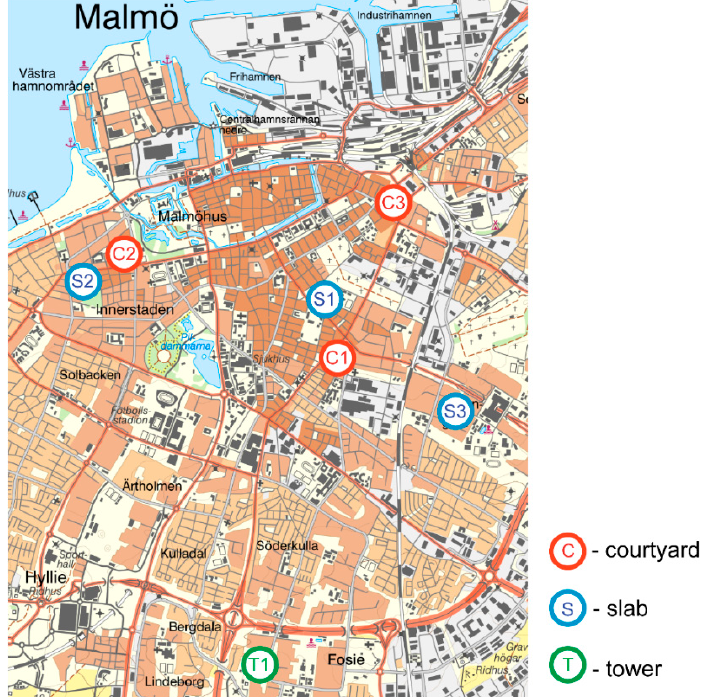
Figure 5. Map of Malmö with neighbourhood case study locations. Background map (1:50,000, raster) © Lantmäteriet (2022).